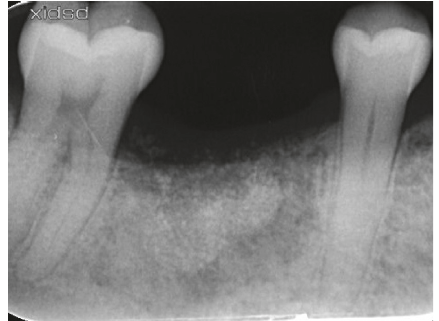
Figure 5: Periapical X-ray at 12 weeks showing that the site is occupied by newly formed hard